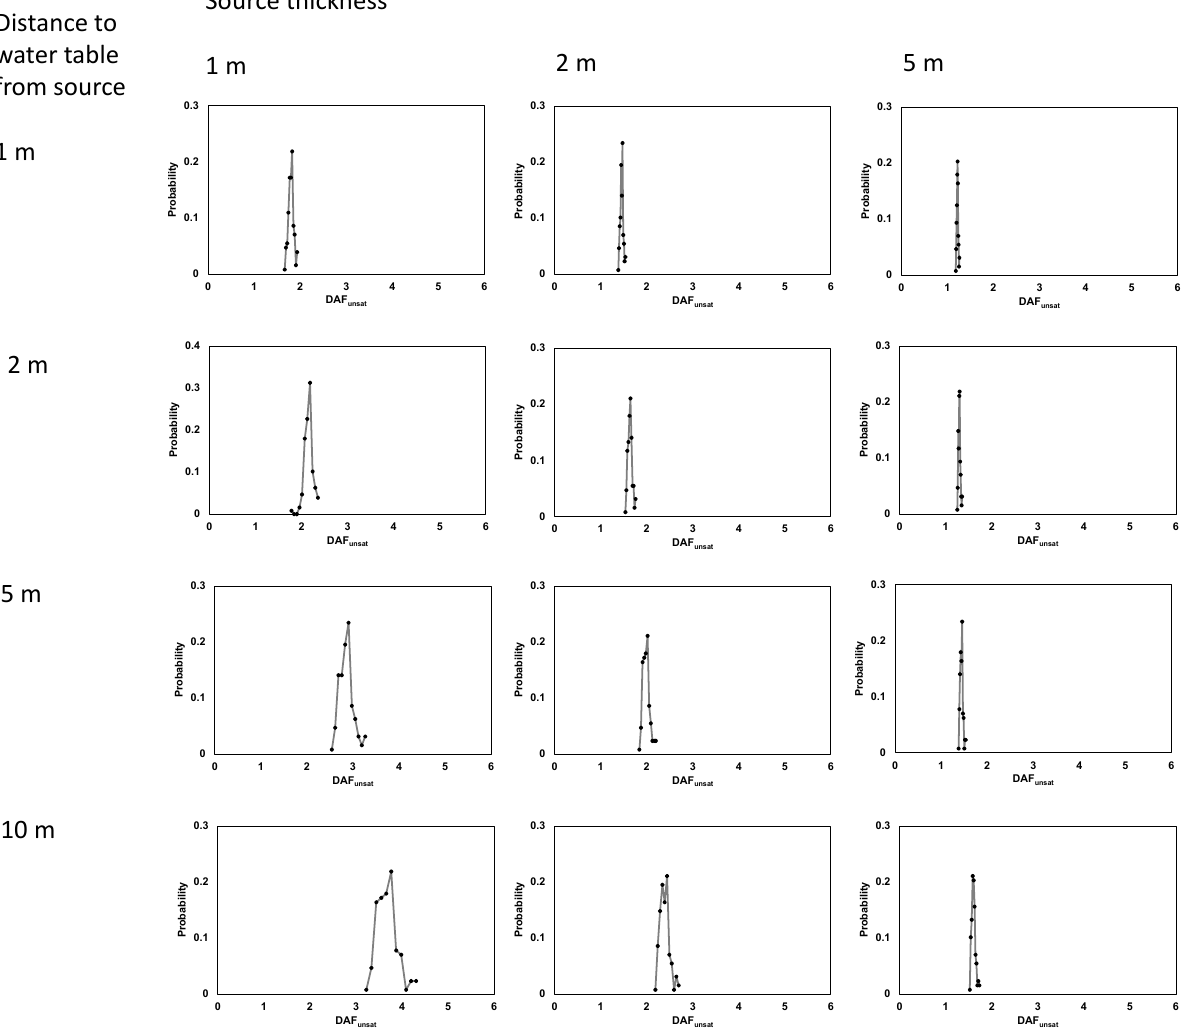
Figure 6. Probability distribution of DAF unsat for a function of source depth, D, and distance from the top to the groundwater level, L.